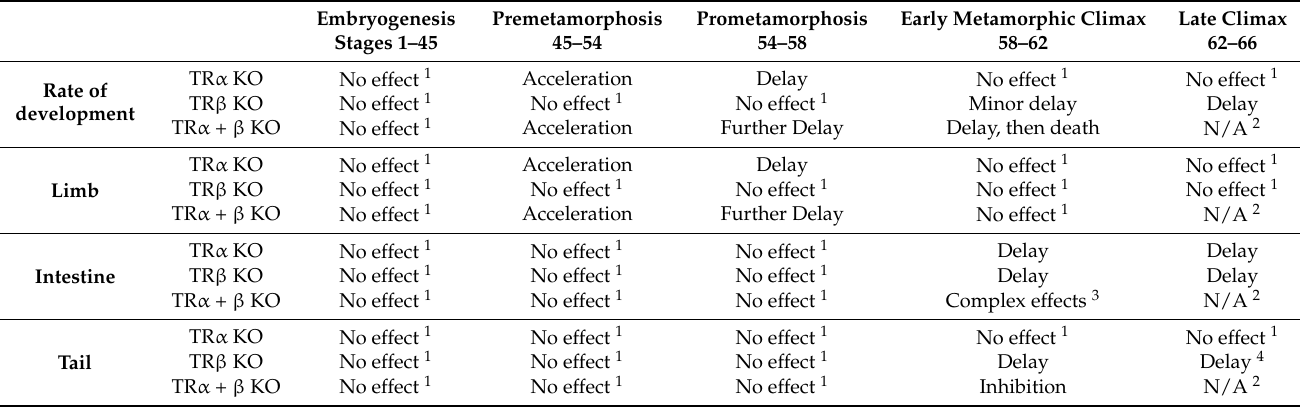
Table 1. Organ-dependent effects in single and double TR α / β knockout Xenopus tropicalis